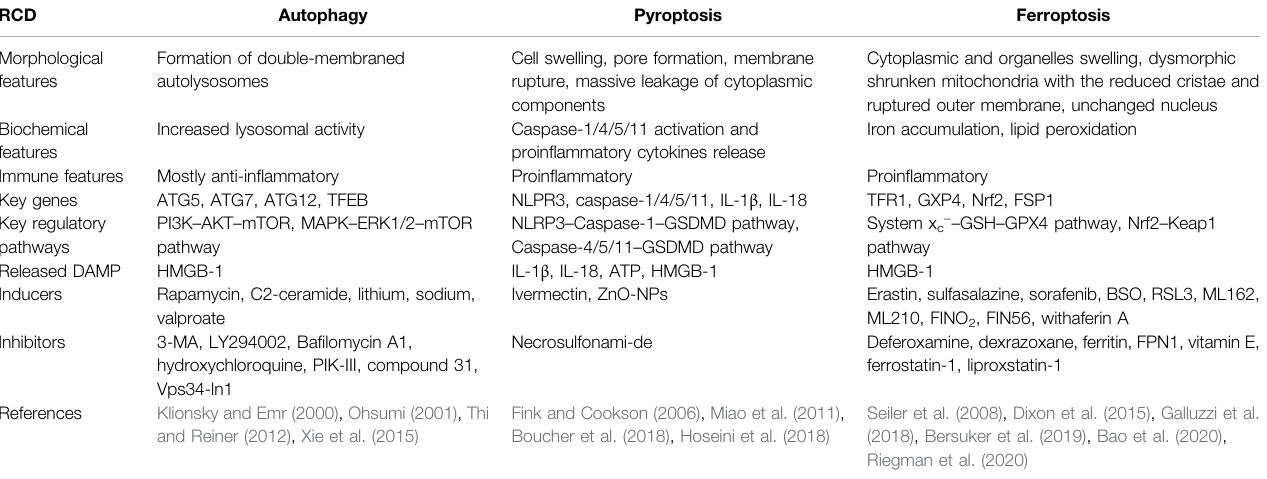
TABLE 1 | The main features of autophagy, pyroptosis, and ferroptosis.